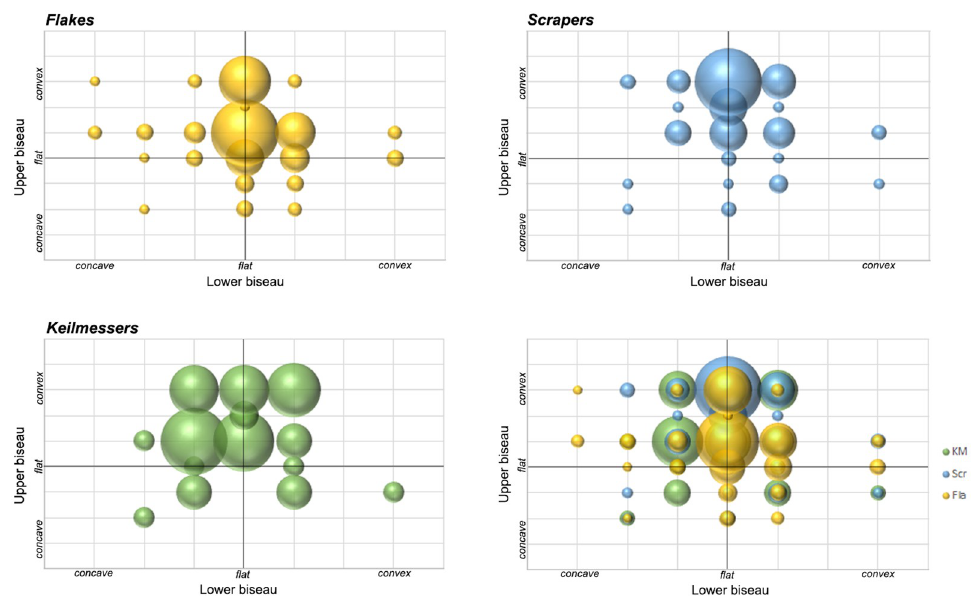
Fig 12. Bubble charts showing the distribution of the classes of cutting edge bevel (lower and upper) for tool type.